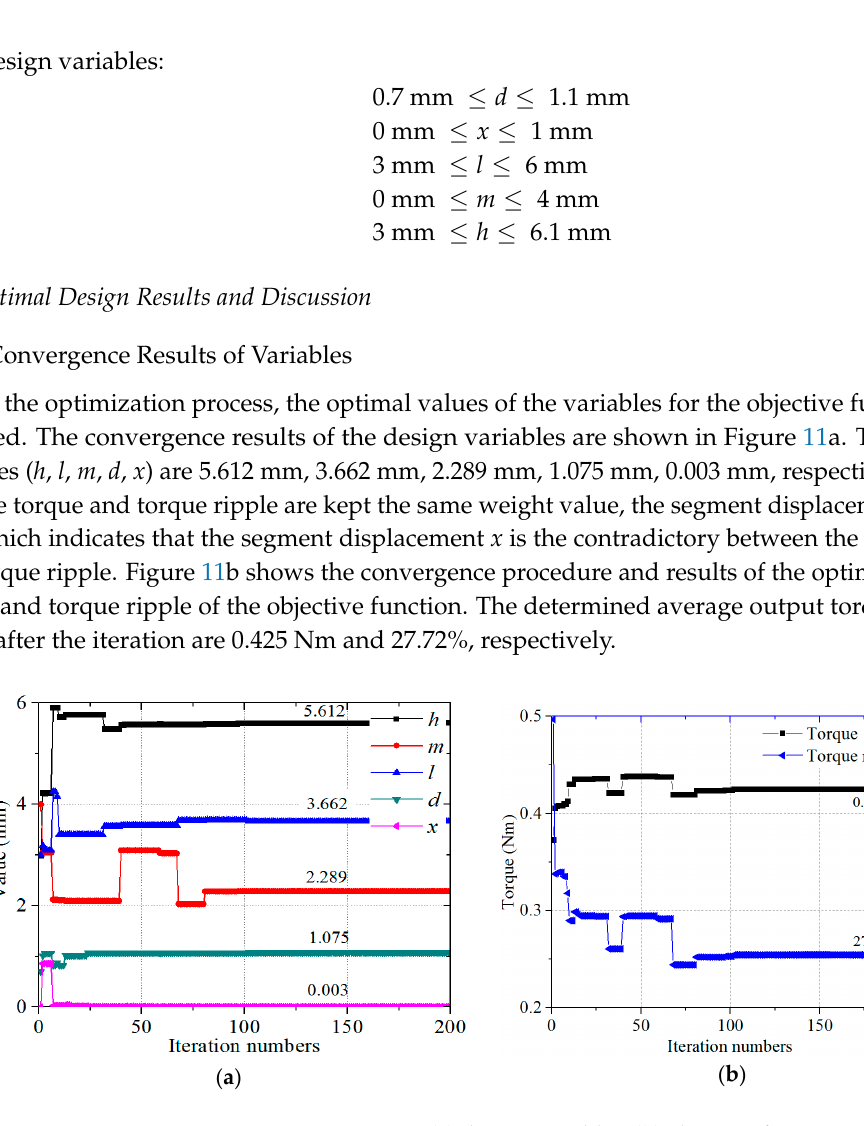
Figure 11. Convergence process: ( a ) design variables; ( b ) objective function.